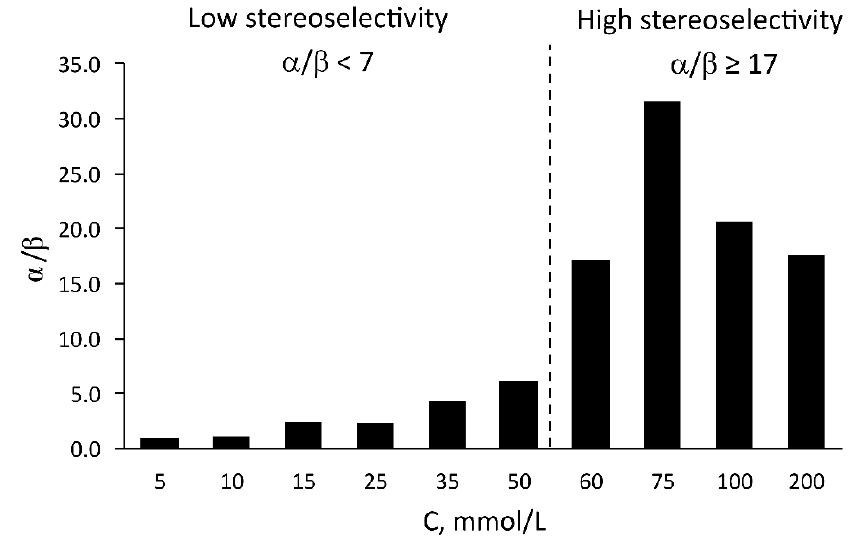
Figure 4. Dependence of stereoselectivity ( α / β ) of glycosylation on concentration ( C ) of N -acetylsialyl chloride 1 (see Scheme 1 and Table 1). Dashed line separates two concentration ranges: at C ≤ 50 mmol/L, stereoselectivity is low (α/β ˂ 7), while at C > 50 mmol/L, stereoselectivity is high (α/β ≥ 17).